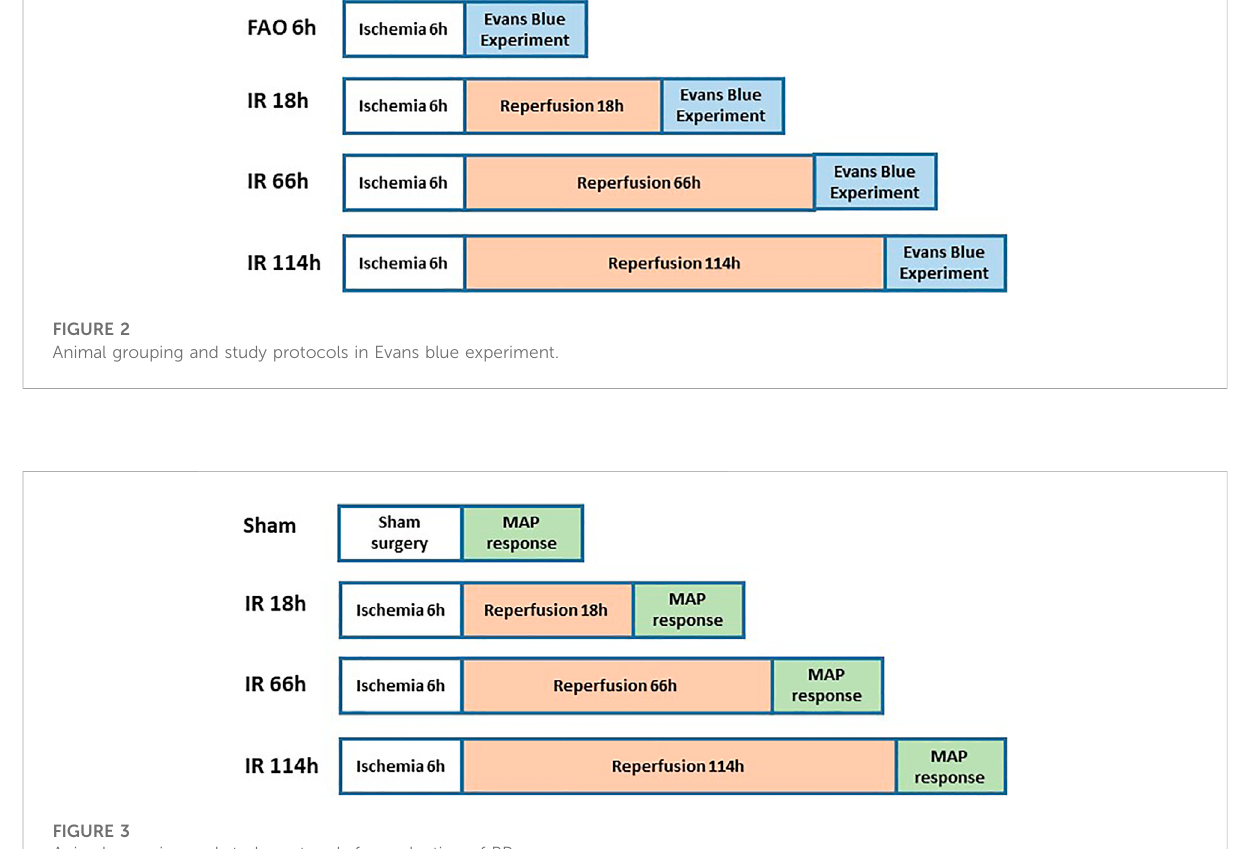
Animal grouping and study protocols for evaluation of BP